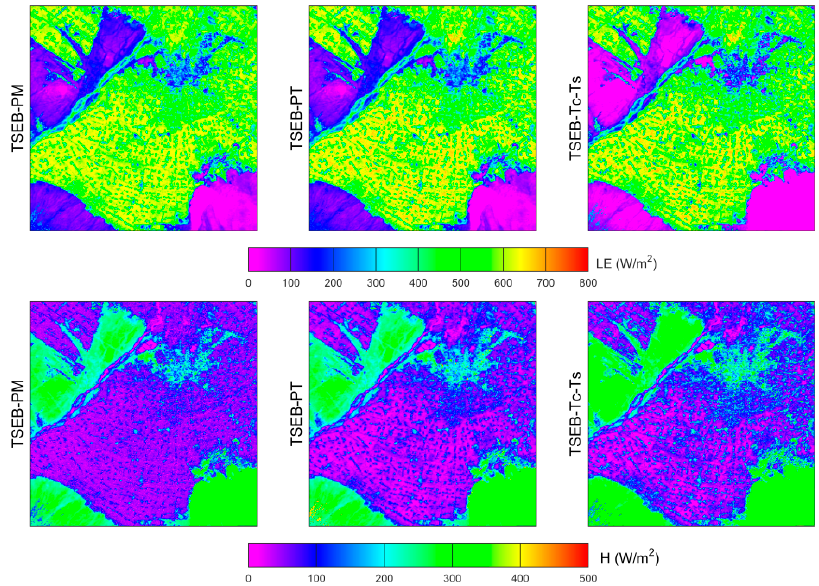
Figure 3. The spatial distributions of LE (first row) and H (second row) over the Zhangye oasis based on TSEB-PT, TSEB-PM, and TSEB- T C - T S for the satellite overpass time on 10 July 2012.